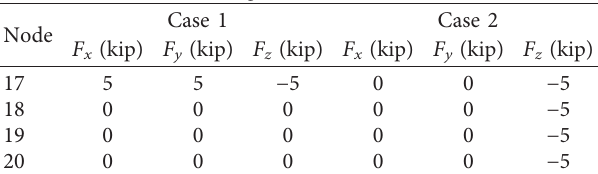
Table 5: The loading condition of the 72-bar